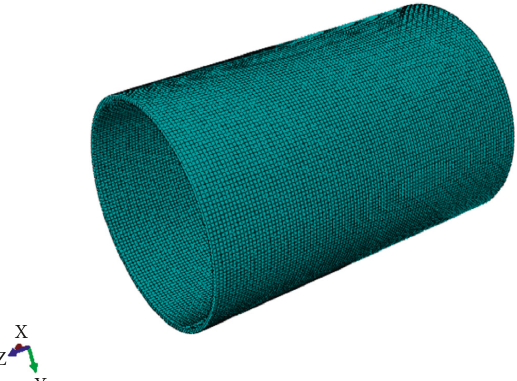
Figure 2: Meshing model of the flawless pipeline.